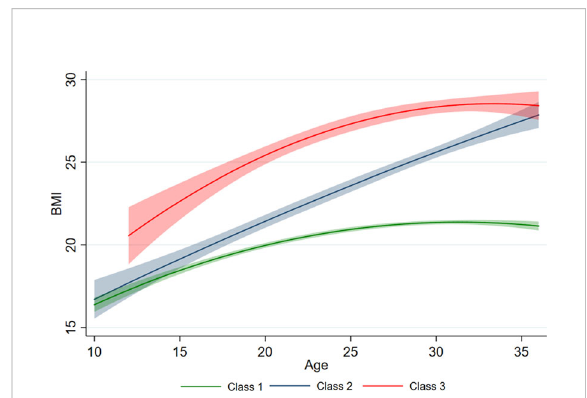
FIGURE 3 Different BMI trajectories developed by measurements of BMI. The predicted trajectory of BMI with age is presented by the solid line, and 95% of the CI is represented by shading.